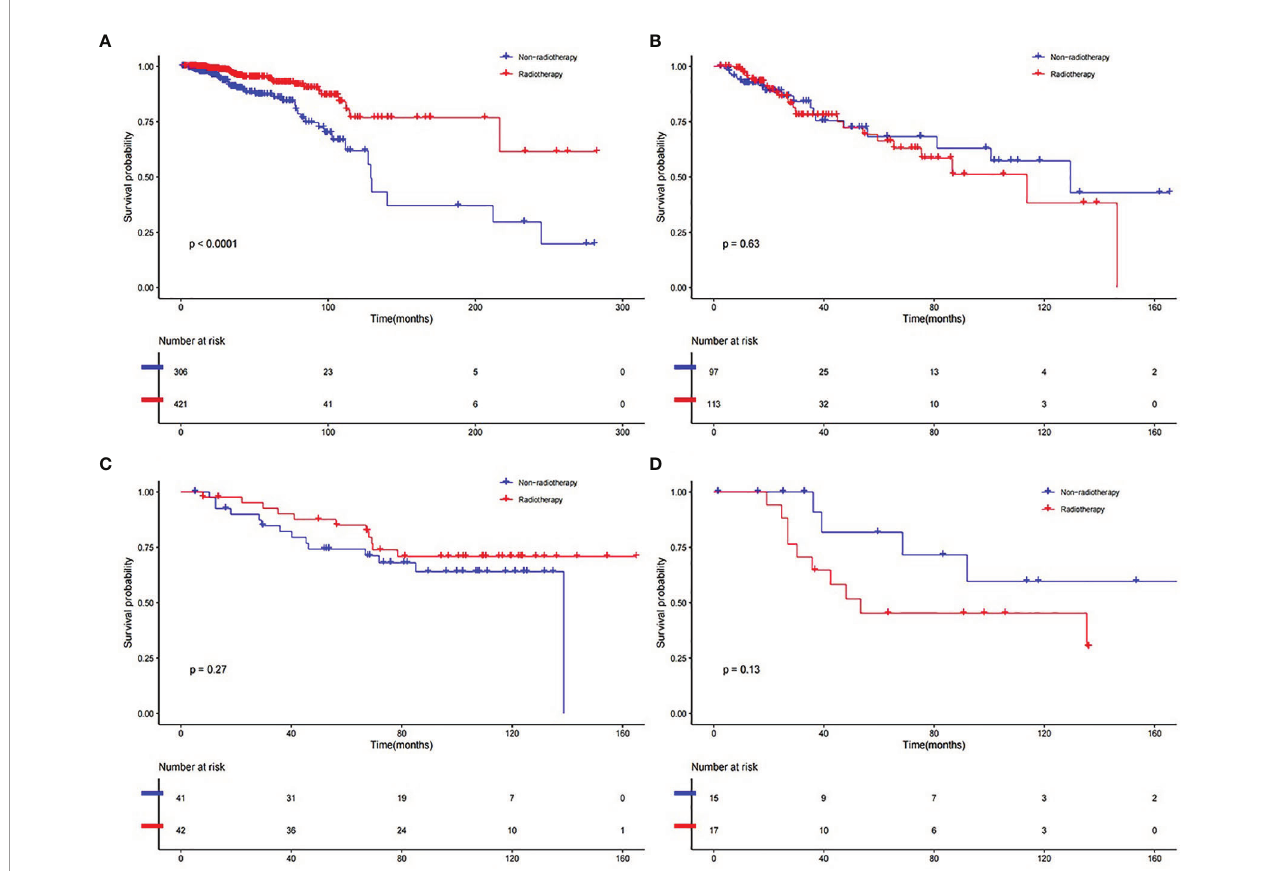
FIGURE 6 | K – M curve of comparison for the RT and Non-RT groups. (A) RS group in developed dataset. (B) RR group in developed dataset. (C) RS group in validation dataset. (D) RR group in validation dataset.